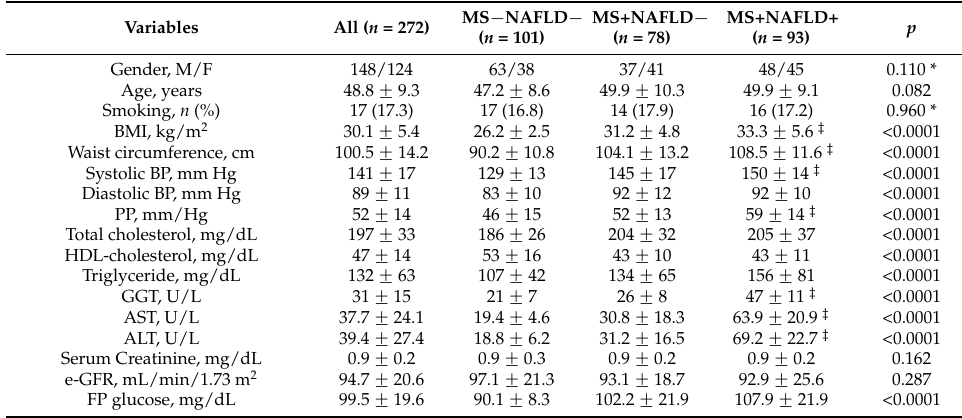
Table 1. Clinical, biochemical and hemodynamic characteristics of subjects in whole study population and in different